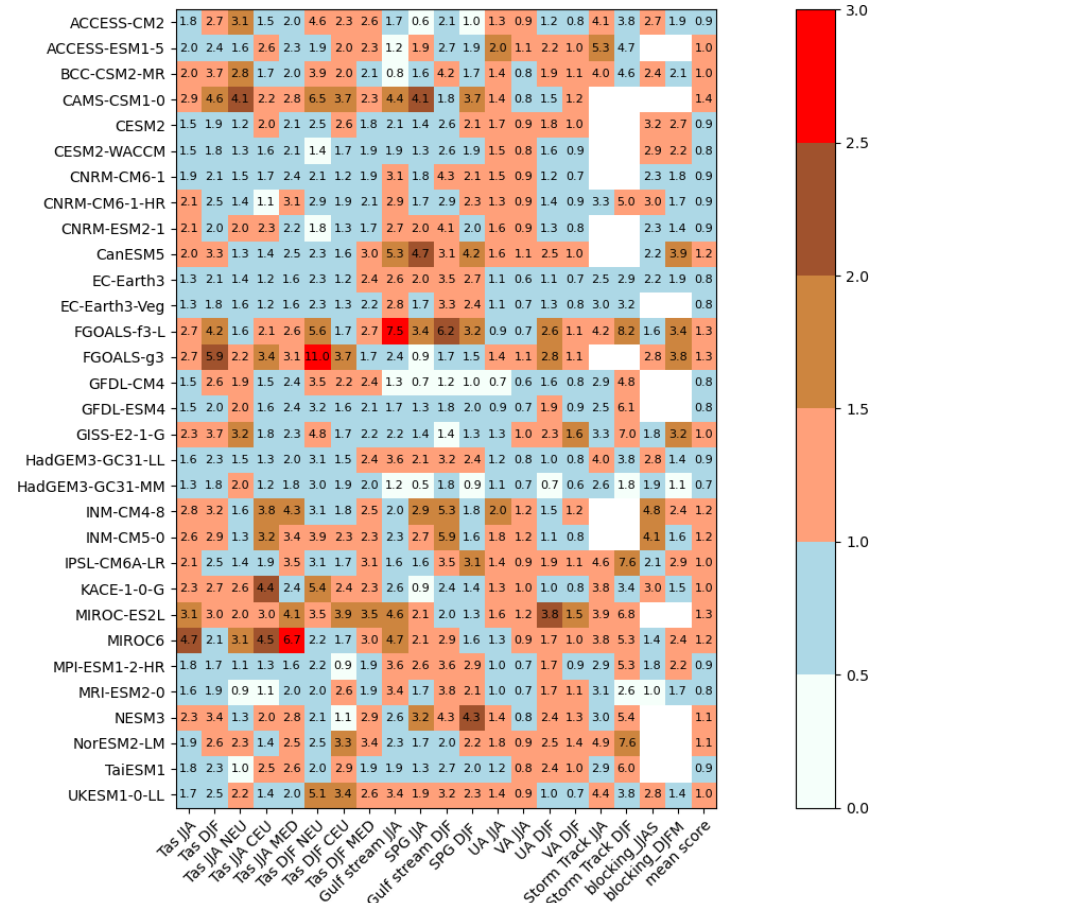
Figure 1. Summary of RMSE values for the large-scale assessment criteria and regional temperature. The regions are abbreviated as follows: northern Europe (NEU), central Europe (CEU) and the Mediterranean (MED). Tas refers to near-surface air temperature, SPG refers to subpolar gyre, and UA and V A are the eastward and northward wind vectors at 850hPa, respectively. The colour scale is determine by the ratio of the model RMSE to the ensemble mean RMSE. RMSE values are absolute, and the mean score is the average of the relative error (normalised by the ensemble mean) across each of the